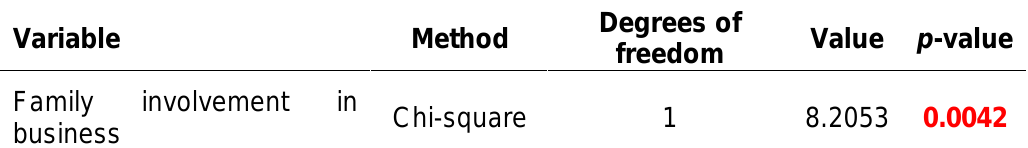
Table 9: Significant Differences Relating to Family Involvement in Business